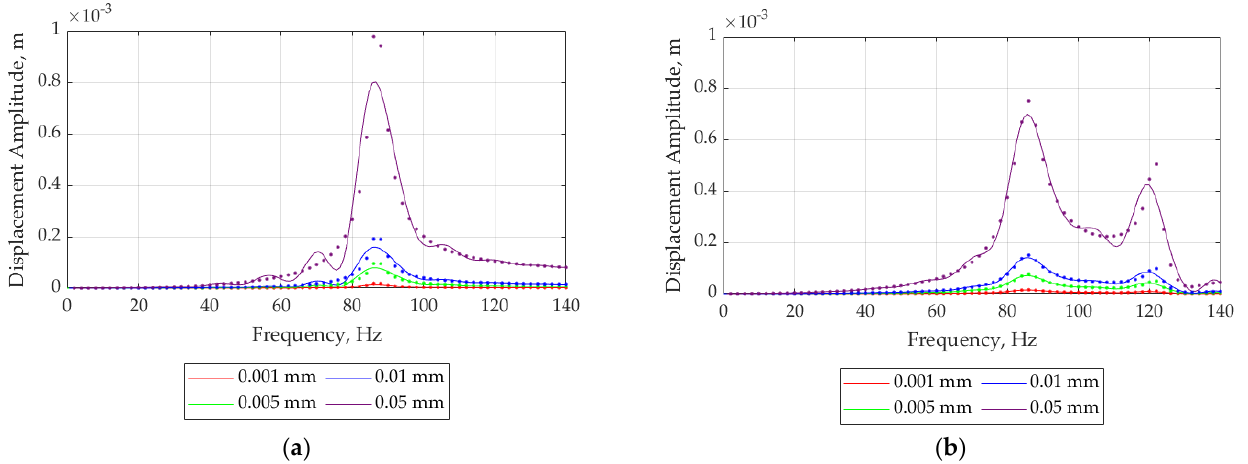
Figure 16. The displacement amplitude as a function of the frequency of the ( a ) 1-DoF and ( b ) 2-DoF levitated magnet for external excitation with constant amplitude of sinusoidal force.